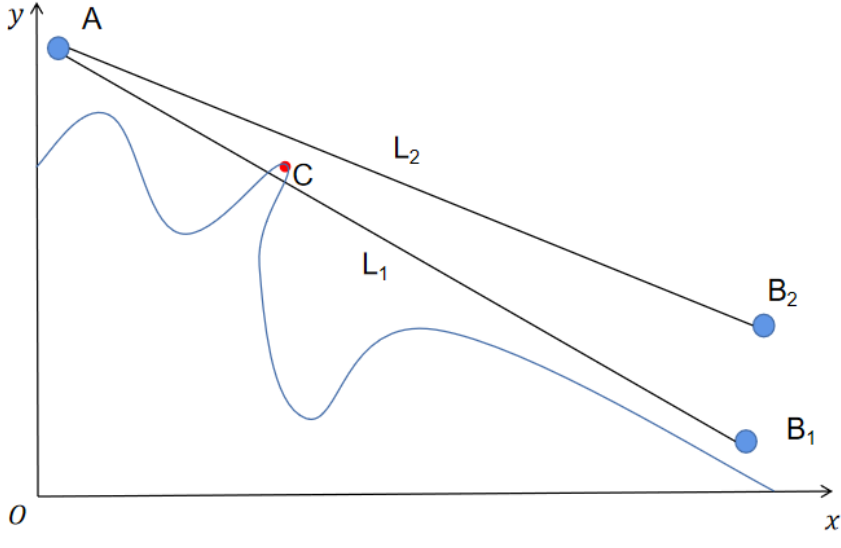
Figure 5. Judging obstacles based on